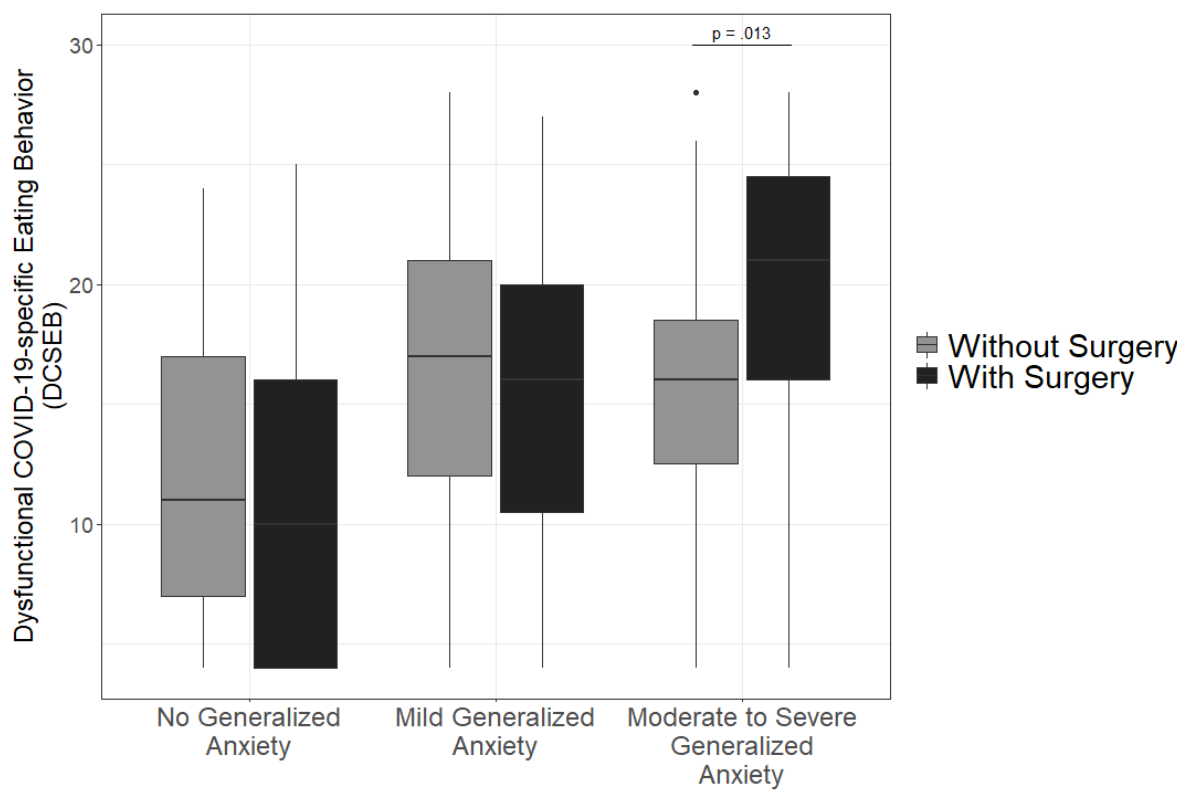
Figure 1. Generalized anxiety as a risk factor for increased levels of dysfunctional COVID-19-specific eating after obesity surgery. Group-wise box-plots indicate medians and interquartile ranges (see supplemental material for illustration of non-splitted continuous data). While for participants with no or mild manifestations of generalized anxiety (GAD-17 scores of 0 to 4, or 5 to 9, respectively), no increase in DCSEB is notable, and individuals with moderate to severe levels of anxiety (GAD-7 > 9) show increased DCSEB after obesity surgery. Whiskers extend to the most extreme data point unless there are data 1.5 inter-quartile-ranges away from the first or the third quartile, respectively. Data points beyond that are shown as a black